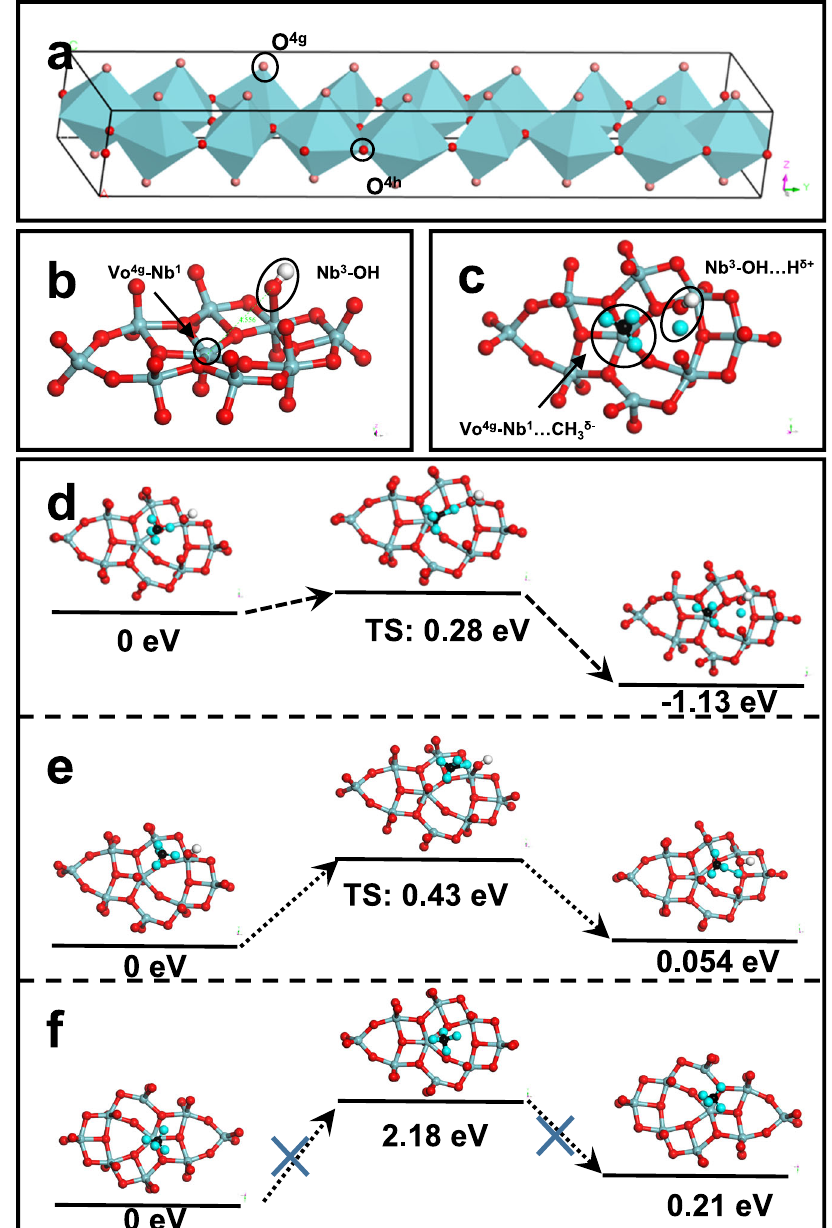
Fig. 4 | DFT calculations for methane activation on FLP sites. a Schematic dia- gram of the unit cell of T-Phase Nb 2 O 5 containing no partially occupied Nb atoms. The color of O 4 g is light red, and O 4 h is red. The Nb atoms are in the centers of different twisted octahedra and pentagonal bipyramids. The color of Nb is blue. b Structure of Vo 4 g -Nb 1 -O-Nb 3 -OH cluster. c Schematic model of methane